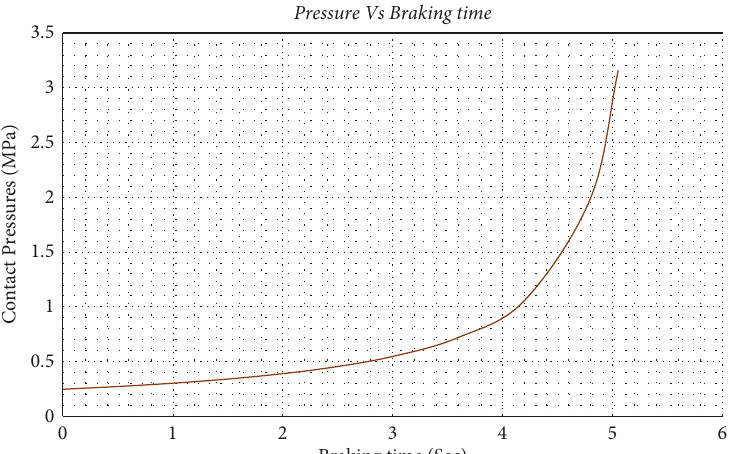
Figure 4: Pressure distribution at different braking times.